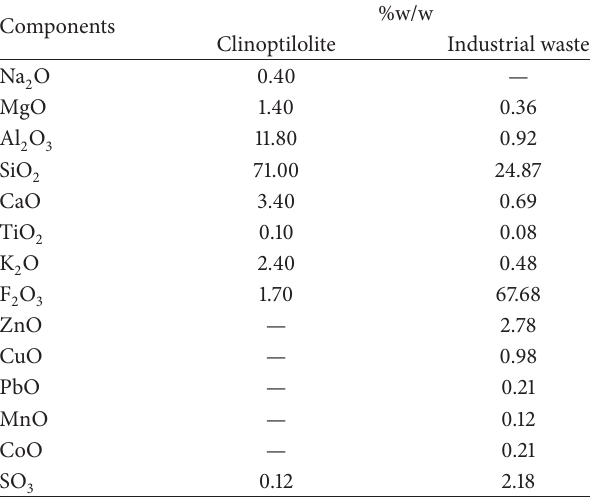
Table 3: The most common MFs and their associated